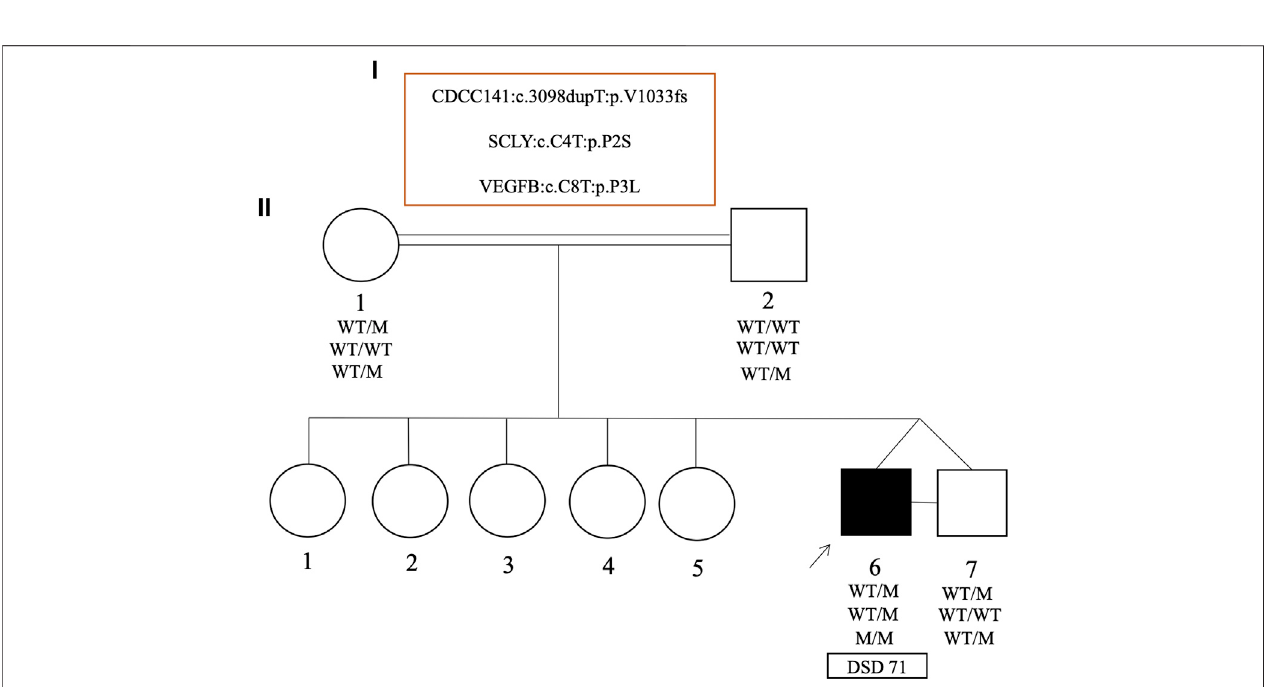
FIGURE4| Distributionofpreviouslyreportedandnovelgeneticvariantsidenti fi edintheDSDcohort. (A) Summaryindicatingtheproportionofpreviouslyreported variants. (B) Theclinicalsigni fi canceofvariantsin84genesidenti fi edinthisstudyamongthesyndromic/non-syndromic46,XYDSDcohort.Thetotalnumberofvariants is shown for each gene, including previously reported variants and novel